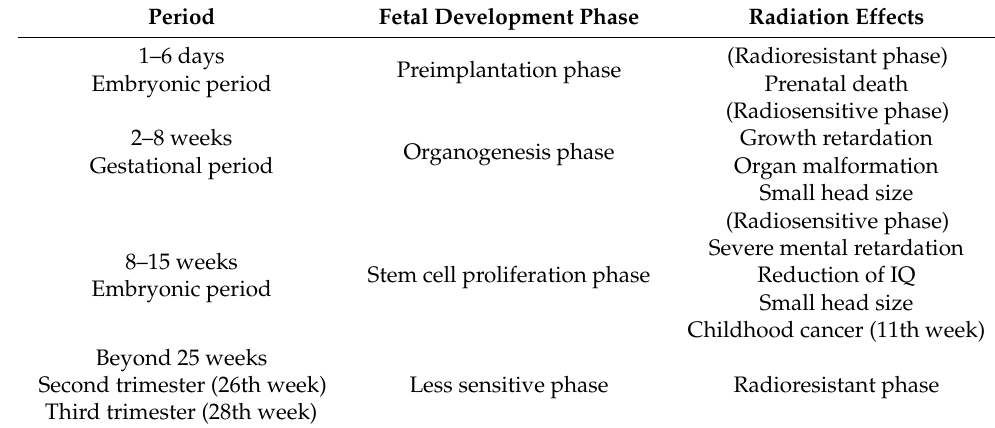
Table 1. The relationship between fetal development phase and radiation effects